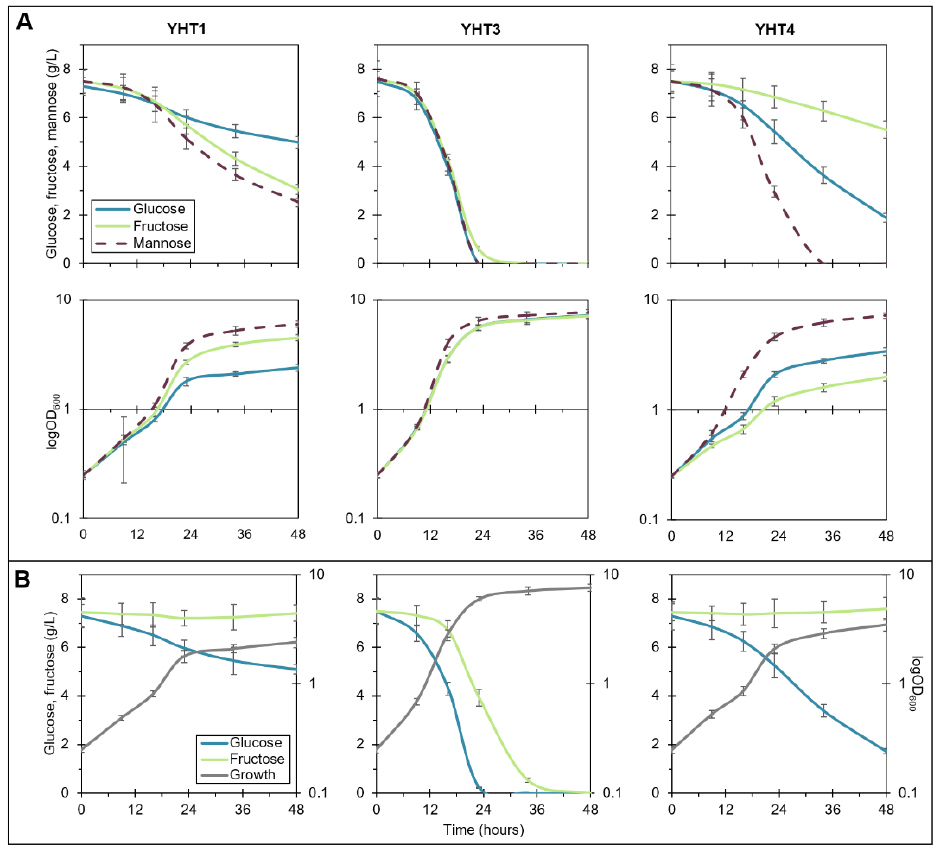
Figure 1. Sugar utilization and growth of S. cerevisiae EBY.VW4000 transformants expressing hexose transporters from Y. lipolytica in single sugar media ( A ) and medium containing a mixture of glucose and fructose ( B ). The cultivations were carried out in three biological replicates.